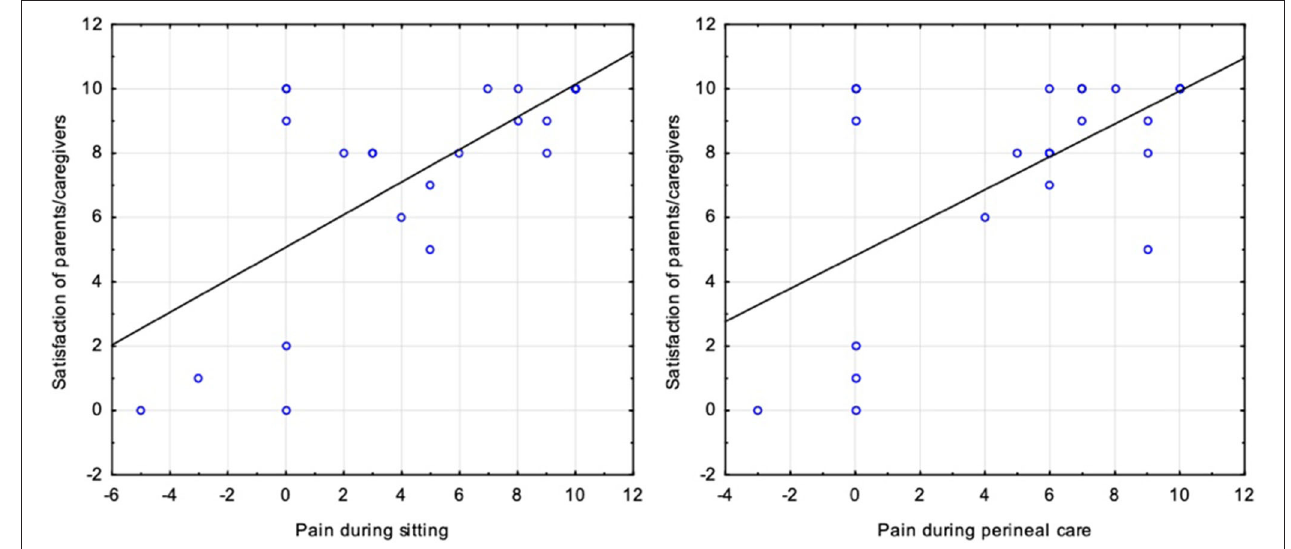
FIGURE 5 | Correlation between Pain and Parents